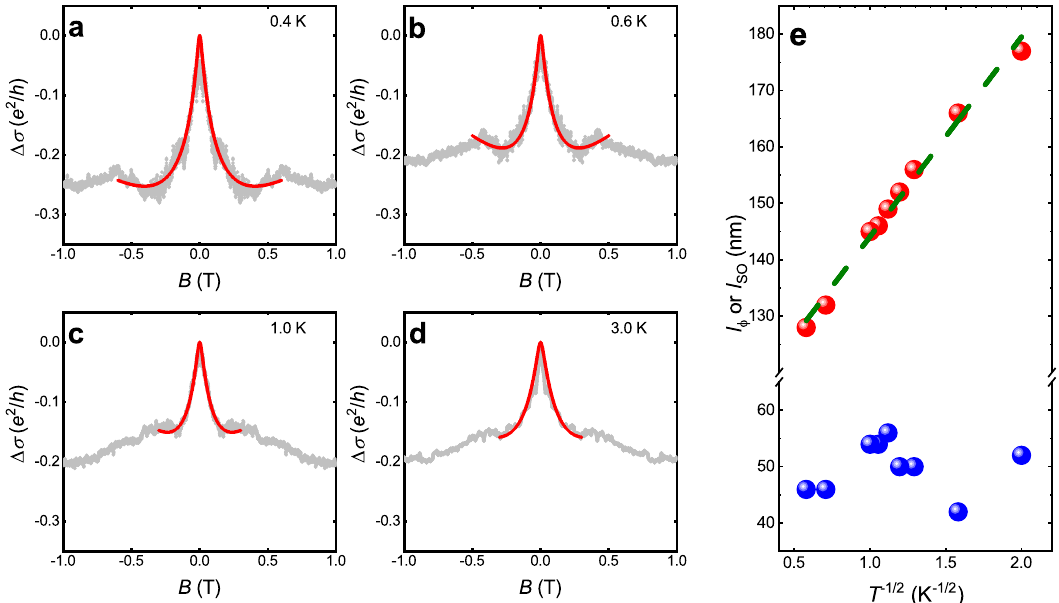
Fig. 4 Fitting of the MC of ETO/KTO. a – d MC at various temperatures. Gray dots are experimental data and red solid lines are fi tting curves based on ILP theory. e The extracted l ϕ (red symbols) and l SO (blue symbols) plotted against T (cid:2) 1 2 . The green dashed line is a linear fi t.